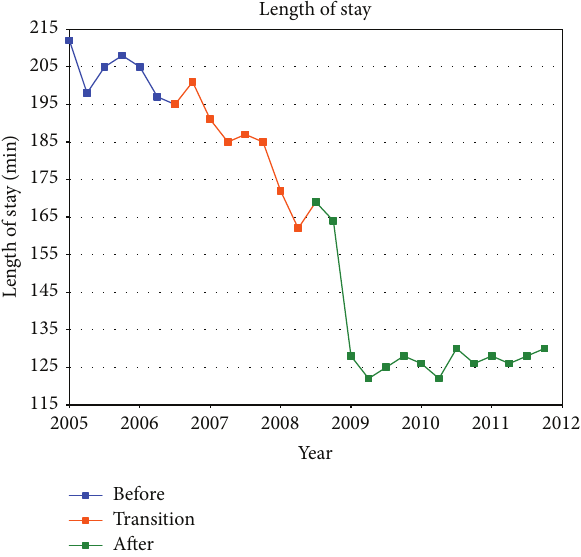
Figure 6: Core Measures: average ED sensitivity quality core mea- sures indicator rates for two conditions. (1) Acute myocardial infarc- tion (AMI): percent of time in which the patient received aspirin and beta-blocker on arrival. (2) Community acquired pneumonia (CAP): percent of time in which the patient received antibiotics within 4 hours and a blood culture prior to administration of antibiotics.